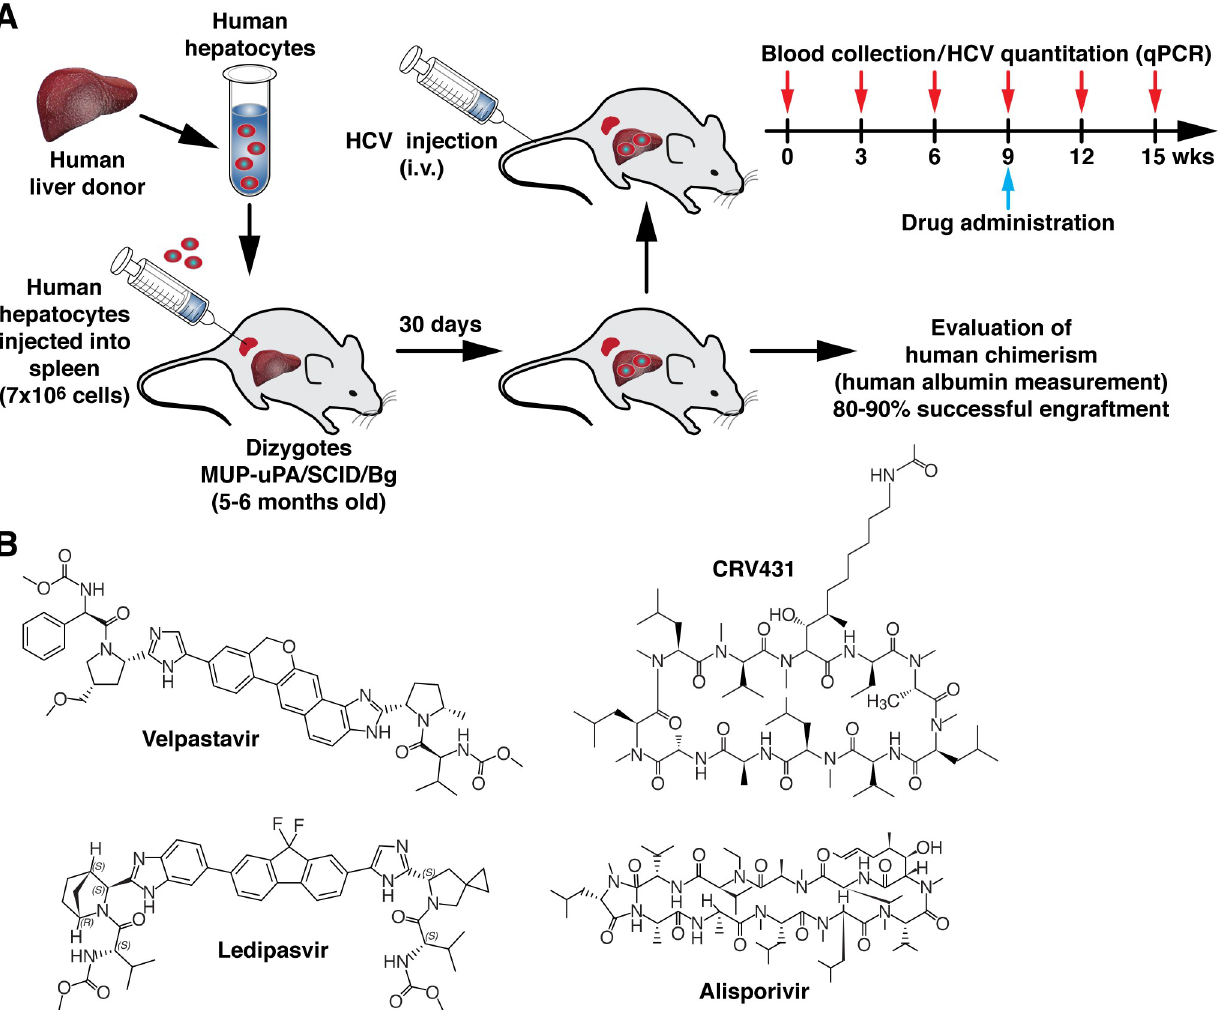
Fig 1. Humanized-liver mouse model for HCV infection. A. Experimental design for the creation and validation of the HCV infection model in humanized-liver chimeric MUP-uPA-SCID/Beige mice. B. Chemical structures of the NS5Ai Velpatasvir and Ledipasvir, and the CypI CRV431 and